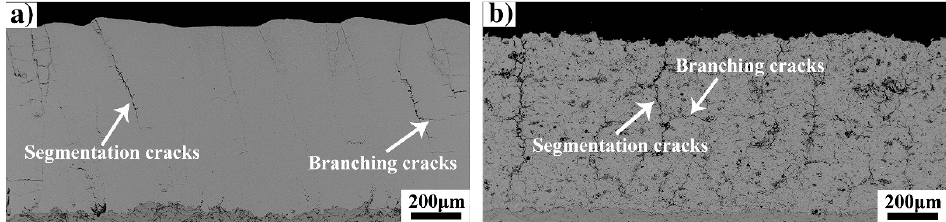
Figure 33. Cross-sectional microstructures of as-sprayed TTBCs: ( a ) SPS ( b ) APS coating [181] .